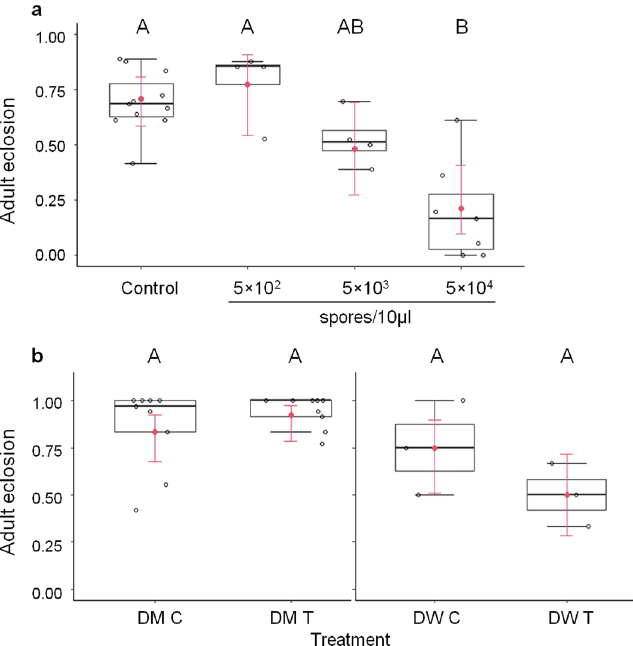
Figure 3. ( a ) D. suzukii adult eclosion (proportion, mean = red dot) at 19 dpi after exposure to different T. suzukii spore dosages (5 × 10 2 , 5 × 10 3 , 5 × 10 4 spores/10 μl) in second instar (L2) larval stage and controls. Replicate/number (R/N): C = 11/408, 5 × 10 2 = 4/180, 5 × 10 3 = 4/204, 5 × 10 4 = 7/264, F = 8.91, DF = 3, P (F) < 0.001. ( b ) Eclosion (proportion) of D. melanogaster (DM T) and D. willistoni (DW T) exposed to 5 × 10 4 T .